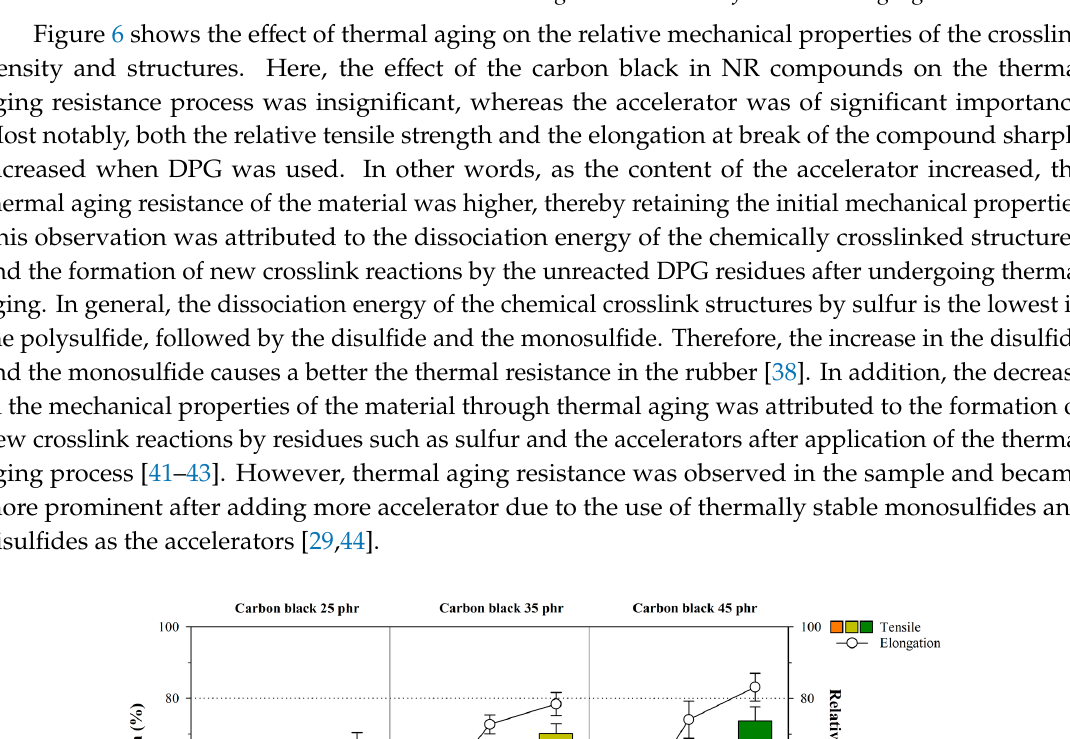
Figure 5. Variation in the mechanical properties in the NR samples by accelerator and carbon black regarding ( a ) tensile strength and elongation at break, and ( b ) hardness.